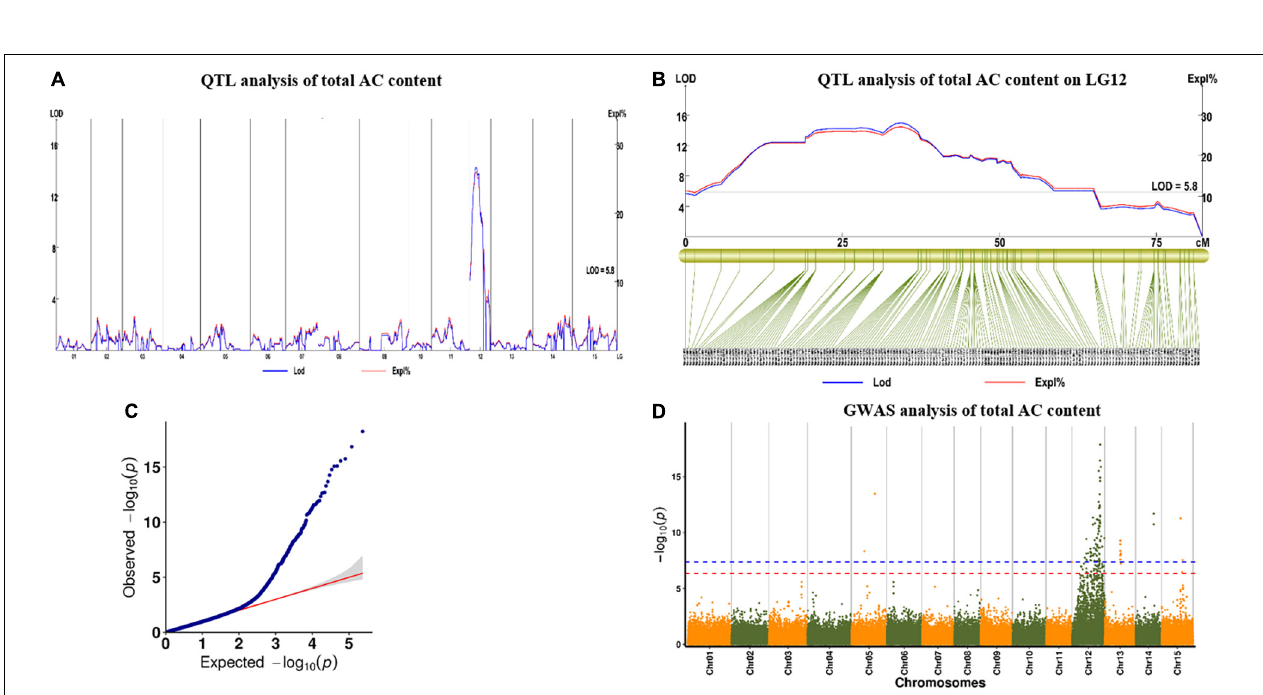
FIGURE 7 | QTL test results of AC by linkage map and GWAS analysis. (A,B) QTL analysis for the AC on LG12; (C) Quantile-quantile plot. (D) Manhattan plot for AC of storage root. The red horizontal dashed line represents the genome-wide significance threshold [–log10(P) = 6.46]. The red triangle corresponds to the proposed functional site. QTL, quantitative trait loci; AC, anthocyanin content; GWAS, genome-wide association study.